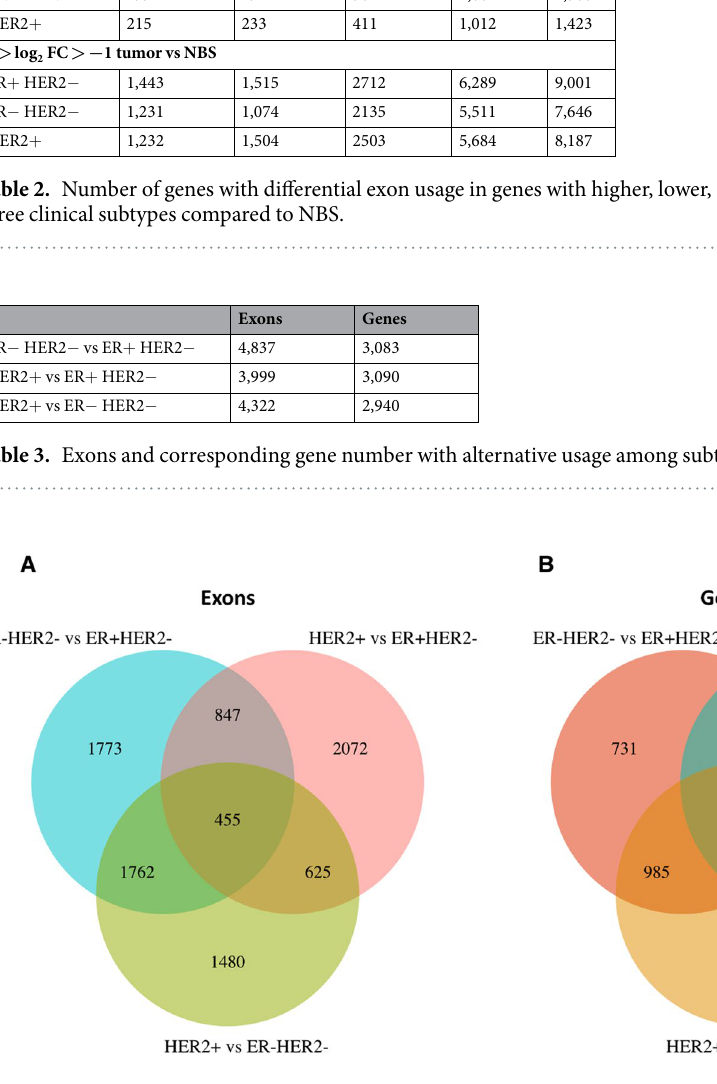
Figure 4. Alternative exon usage among subtypes. The number of differentially spliced or transcribed exons ( A ) and genes ( B ) when all three tumor subtypes were compared.